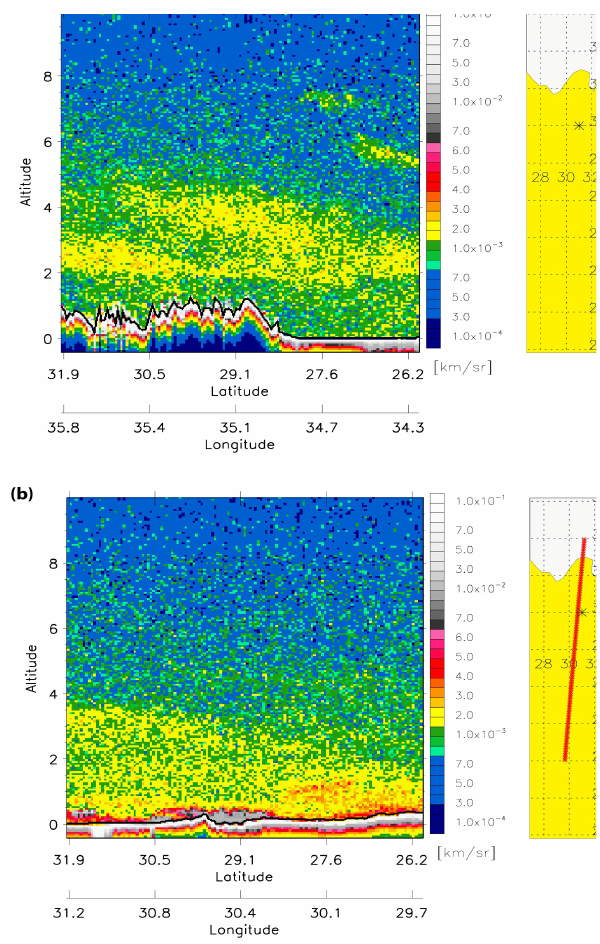
Fig. 6. CALIPSO total attenuated backscatter, (a) on 16 April 2007 at 23:31UTC and (b) and on 30 October at 23:42UTC. The black line represents the surface elevation. The yellow small map repre- sents the location at the Nile Delta including Cairo and the red line represents the calypso